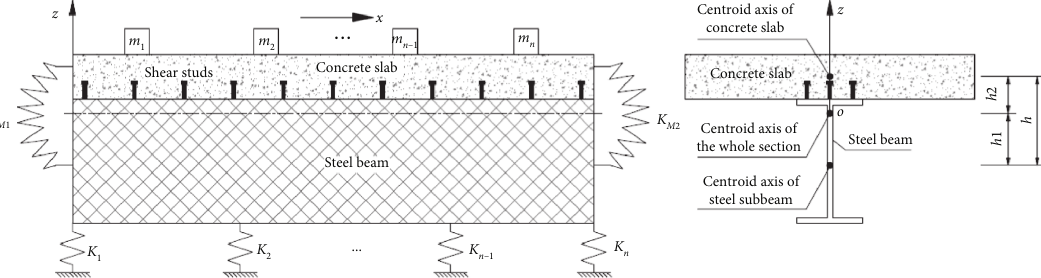
Figure 1: SCCCB longitudinal and cross-sectional